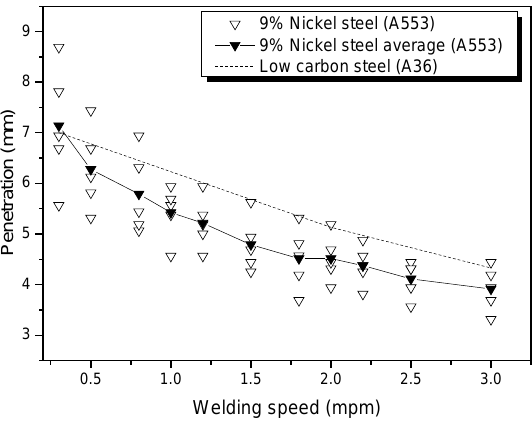
Figure 15. Penetration fluctuation of surface beads, according to welding speed.